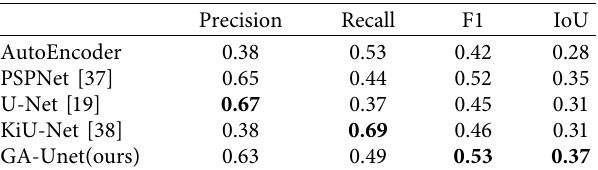
Figure 6: The result of GA-Unet and U-Net at different epoch. (a) original pavement image. (b) ground truth. (c) the results at epoch 50. (d) the results at epoch 100. (e) the results at epoch 200. (f) the results at epoch 300. In (c), (d), (e), (f) images, the upper line is the result of U- Net, and the down line is the results of GA-Unet. Table 1: The comparison of the test results on the concrete pavement image